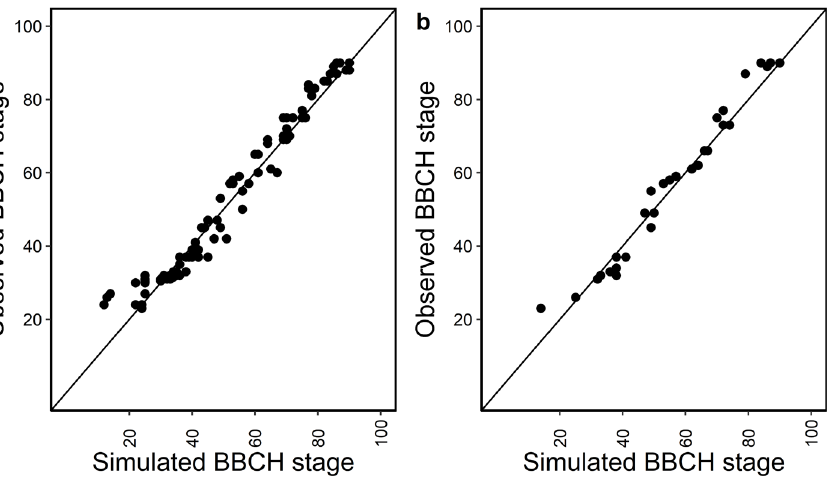
Figure 1. Performance of APSIM winter wheat with current set of calibrated parameters to simulate phenology with ( a ) calibration and ( b ) evaluation data sets using cultivar Dan_winter. Note: BBCH stages from the simulations were extracted based on the date of observations in the field. Table 1. Performance of APSIM (7.10) winter wheat with current set of calibrated parameters (Dan_winter cultivar) under calibration and validation data sets in this study in comparison with default cultivar, and modified cultivar used in [25].